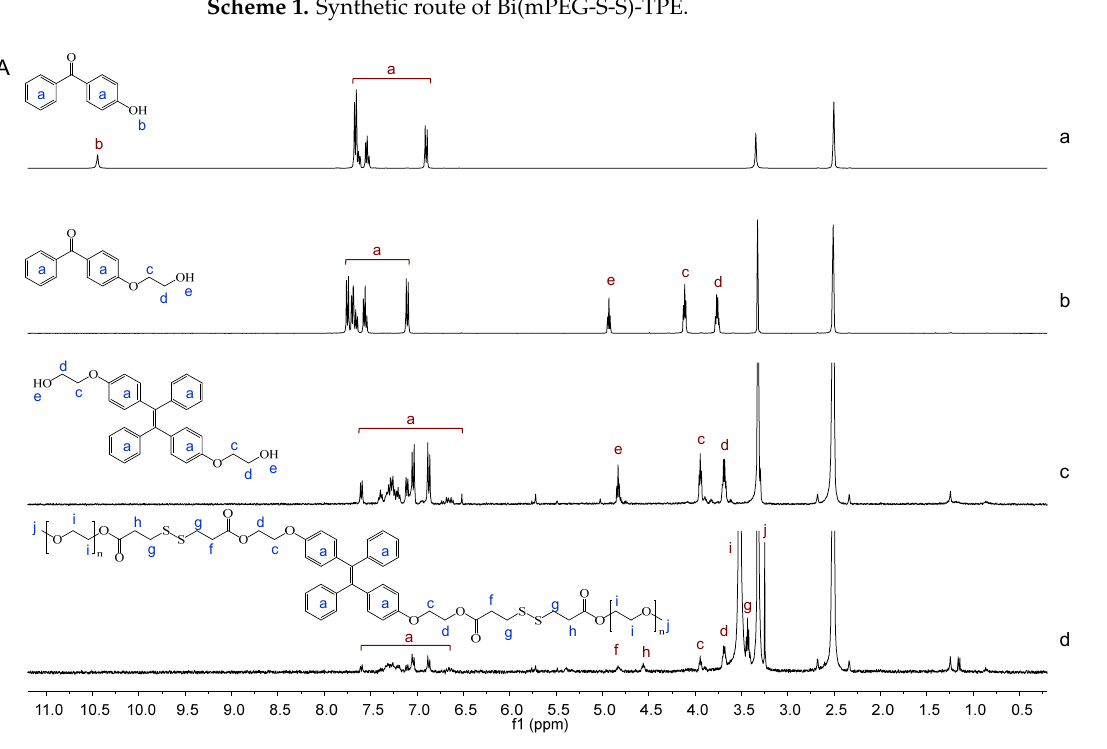
Scheme 1. Synthetic route of Bi(mPEG-S-S)-TPE.